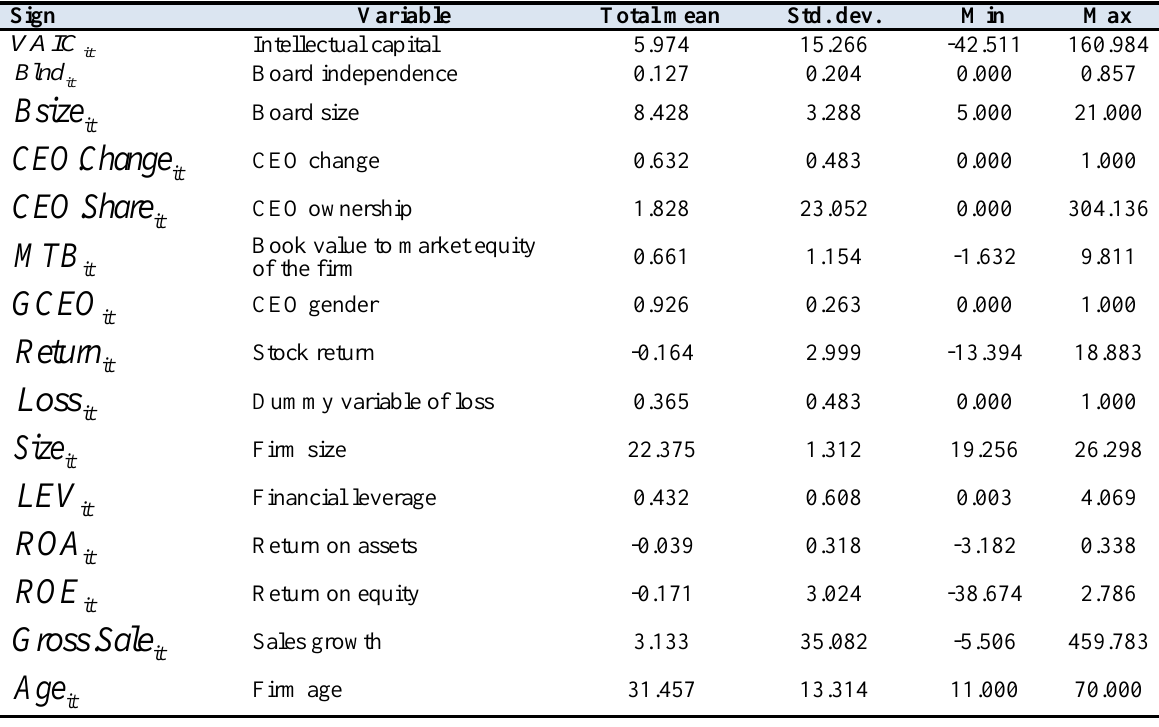
Table 3. Descriptive statistics for Iraqi